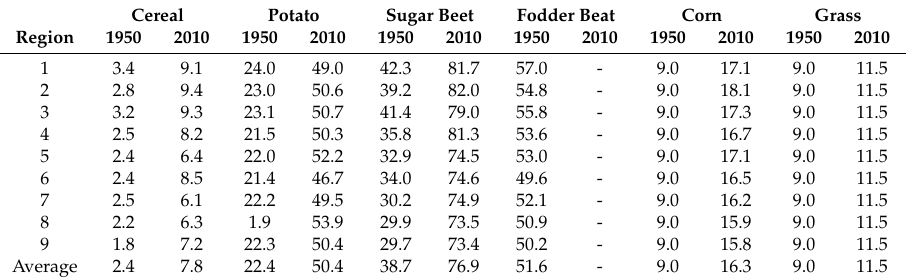
Table 2. Area division of main crops in the province of Noord-Brabant.